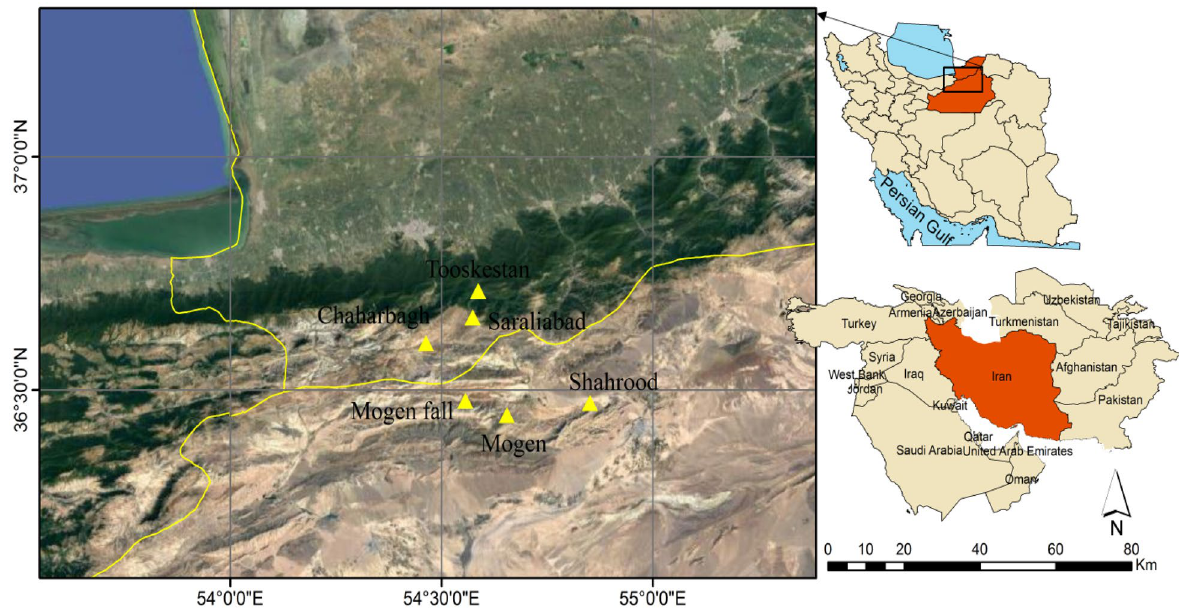
Figure 4. Map of the study area in Northeast of Iran, in which site locations are shown. The following map has been generated in َ Arcmap ver. 10.2 (https:// www. esri. arcGIS. deskt op.